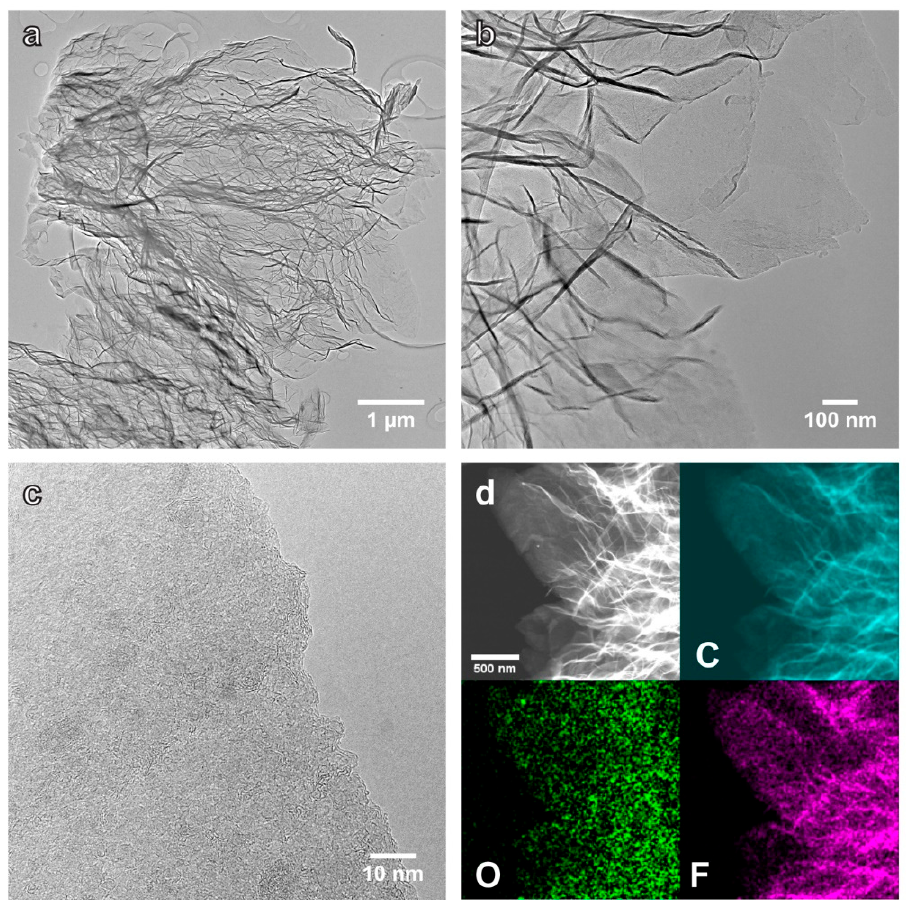
Figure 3. ( a , b ) Bright-field TEM images of the MEGF platelets. ( c ) TEM image over an edge area of a thin MEGF platelet, showing a heavily distorted structure. ( d ) STEM-HAADF image and elemental maps of C, O, and F on the MEGF platelets.